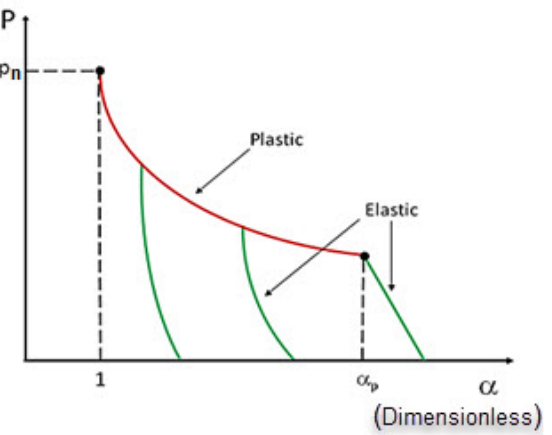
Figure 14: alpha equation of state for the Behavior of the material